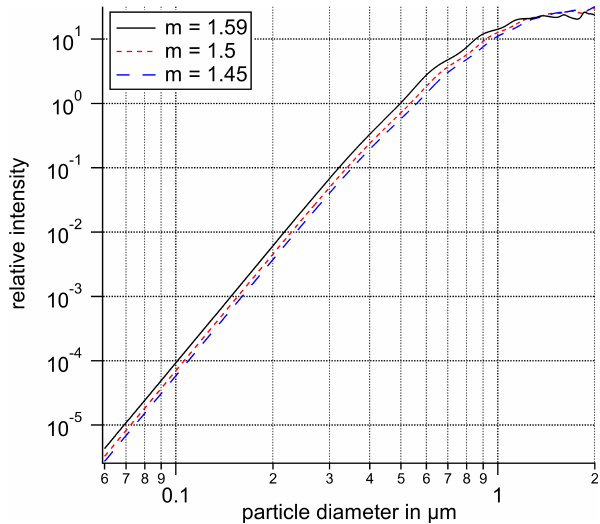
Figure A5. Relative intensity at the detector of UHSAS-A calcu- lated for the refractive index of PSL particles ( m = 1 . 59), ATAL aerosol particles ( m = 1 . 5), and stratospheric aerosol particles ( m = 1 .